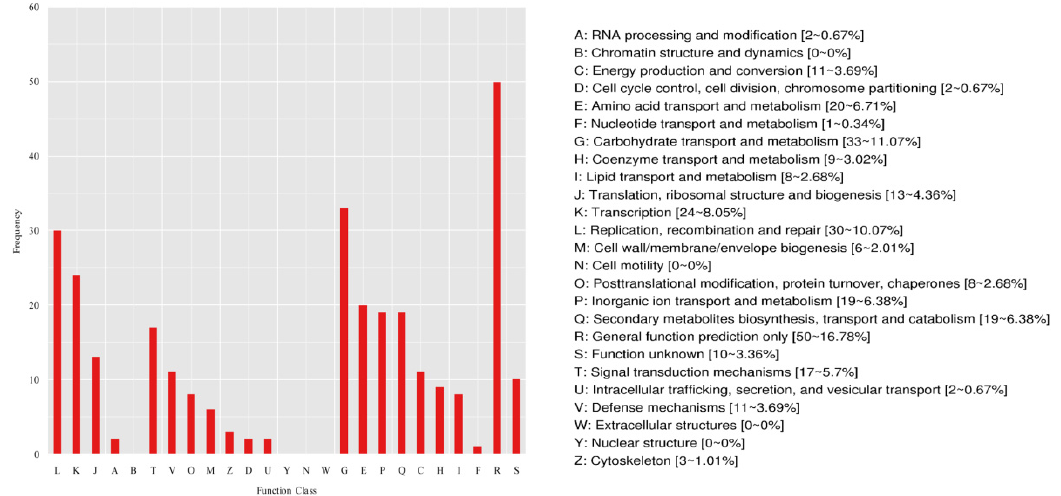
Figure 5. Clusters of orthologous group (COG) of proteins annotation classification of DEGs.